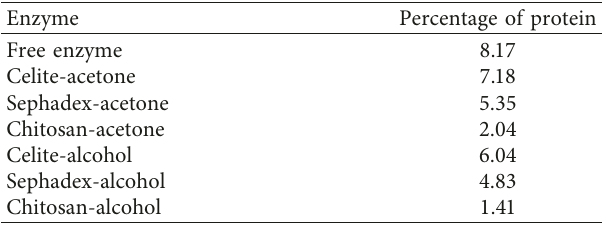
Table 1: Percentage of protein after lipase immobilization on different support